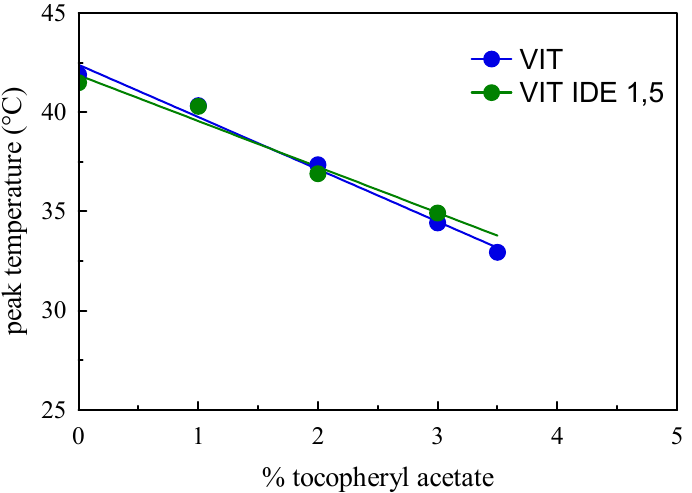
Figure 8. Peak temperature of NLC (unloaded NLC = VIT; 1.5% w / w , IDE-loaded NLC = VIT IDE1,5), as a function of the percentage of tocopheryl acetate.